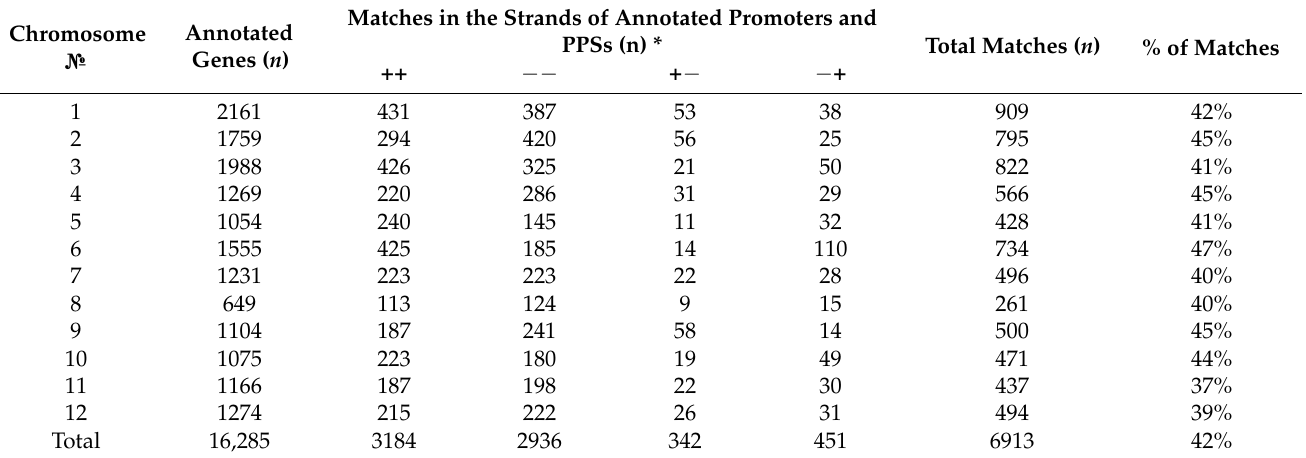
Table 3. Matches of the detected PPSs with promoter regions of the annotated genes in the C. annuum genome (Z ≥